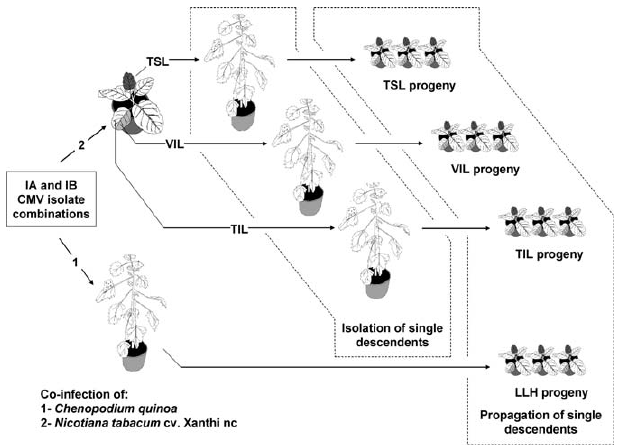
Figure 1. Outline of Double Inoculation Experiments with IA and IB CMV Isolates Four IA and IB isolate combinations were inoculated in C. quinoa or in tobacco cv. Xanthi-nc. In tobacco, total RNA was extracted from inoculated (TIL) and systemic infected (TSL) leaves and encapsidated RNA was extracted from inoculated leaves (VIL). Local-lesion descendents were isolated in C. quinoa and transferred to tobacco Xanthi-nc for propagation.